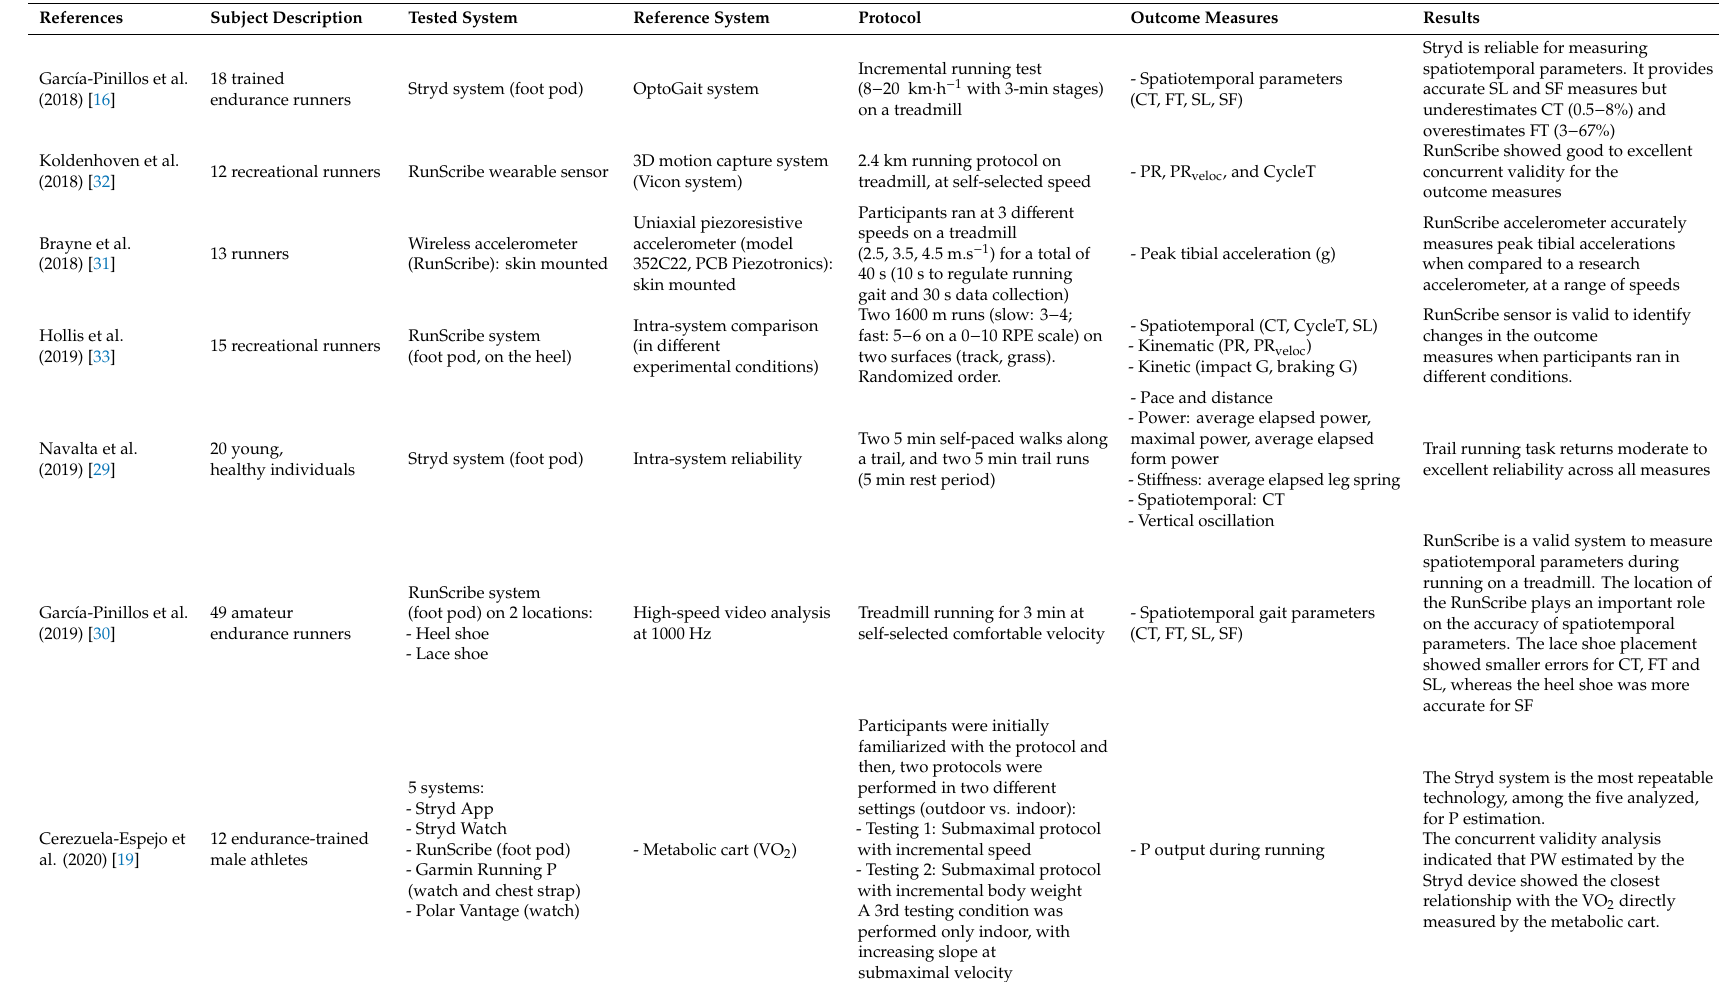
Table 2. Studies ( n = 7) examining the reliability and validity of di ff erent wearable sensors with the capacity to measure power during